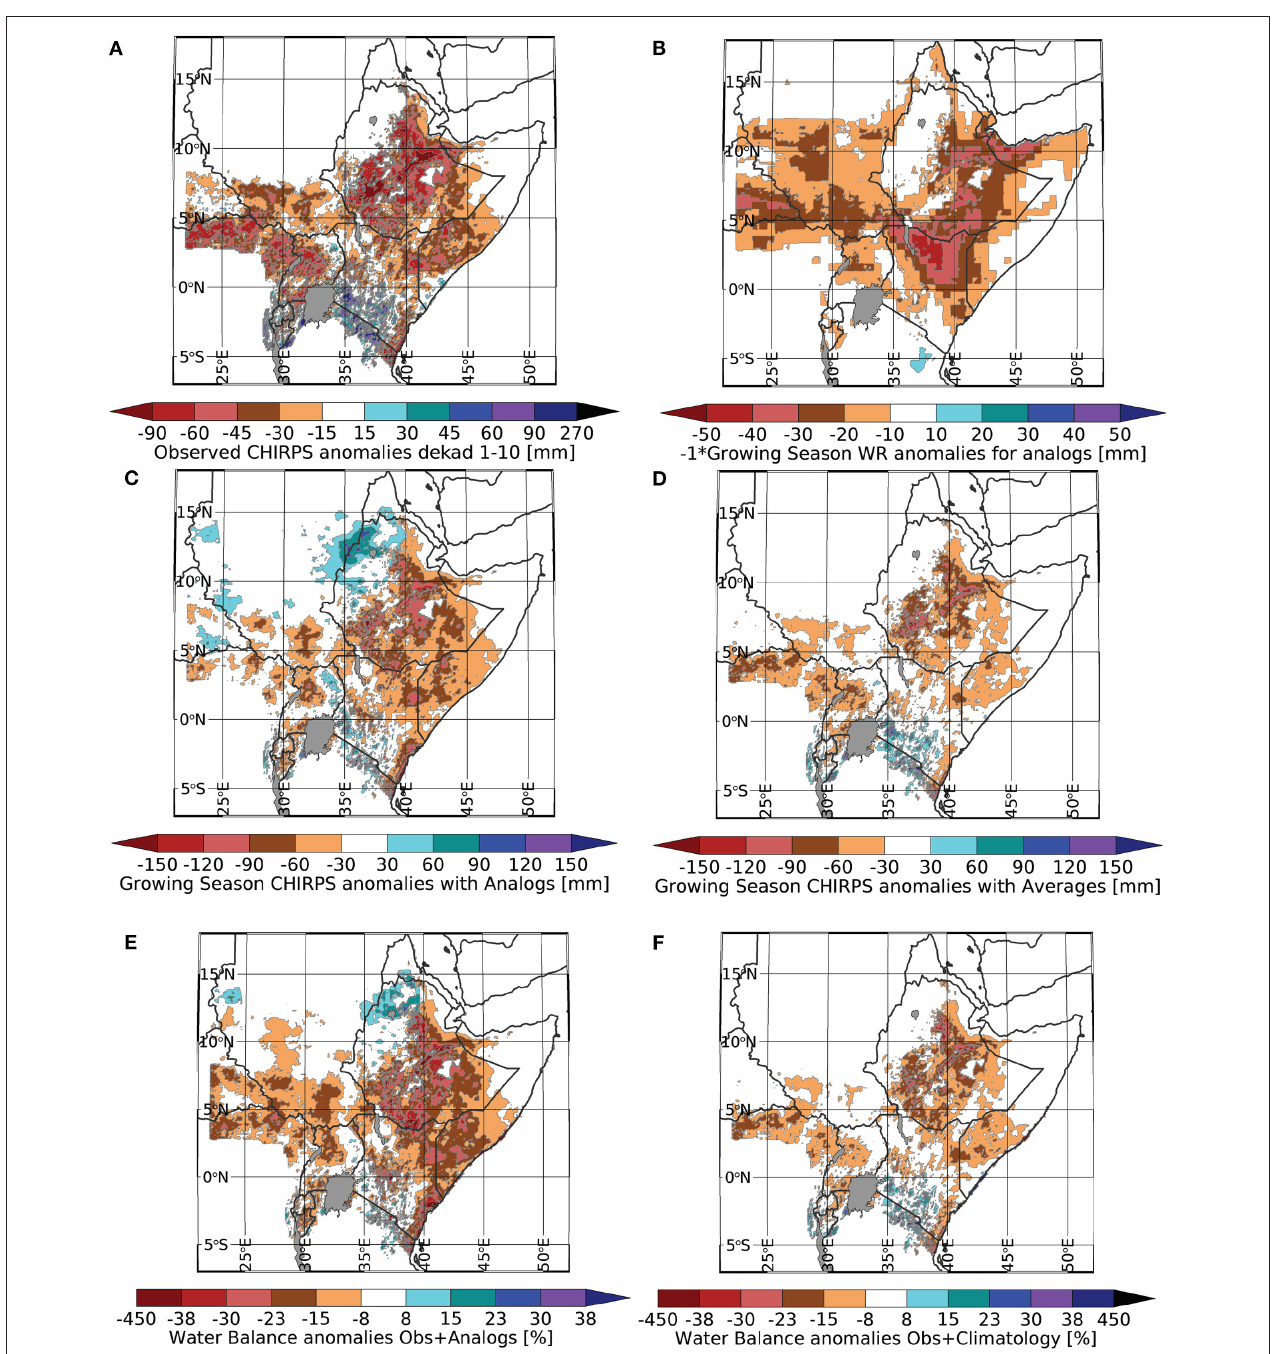
FIGURE 7 | An Agro-Pastoral Outlook example for 2021. (A) Early season rainfall anomalies through dekad 10. (B) Average growing season WR anomalies for analog seasons. (C) 2021 GSP CHIRPS anomalies based on analogs for dekads 11–36. (D) Same but based on long-term averages. (E) The predicted end-of-season WB anomalies associated with the analog forecast assumption shown in (C) . (F) The predicted end-of-season WB anomalies associated with the climatological forecast shown in (D) . (C, D) All anomalies based on a 1981–2020 period of record.